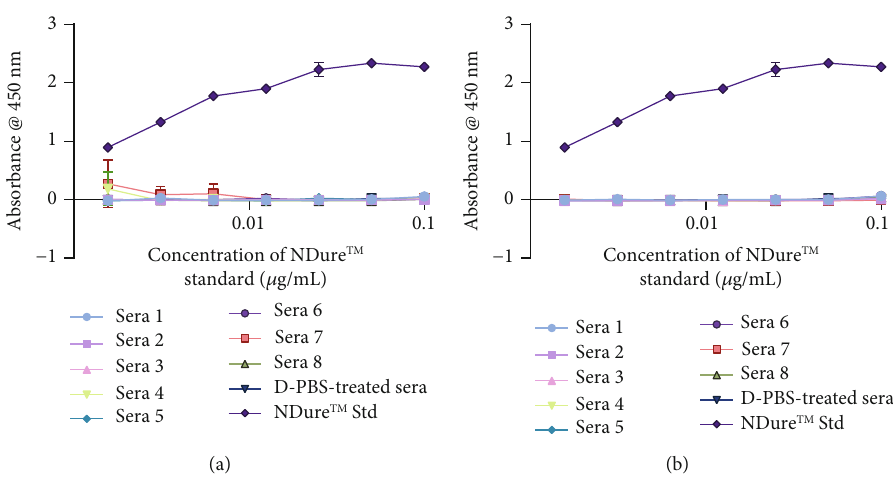
Figure 6: Detection of nonspeci fi c background signals in drug- and D-PBS-treated serum samples . (a – b) Detection of a nonspeci fi c binding response from 1 mg/kg Quad-X ™ - and Humira®-treated mouse serum samples, respectively. In a direct-binding ELISA, 2 μ g/mL human serum albumin (HSA) was used as coating antigen and nonspeci fi c binding was measured using an anti-mouse IgG- (whole molecule) peroxidase antibody. The results shown are the mean ± SD ( n = 2 with three replicates per experiment, except for the pooled NDure ™ Std data which is an n = 4 with two replicates per experiment). p > 0 : 99 for all Quad-X- and Humira-treated serum samples vs. D-PBS-treated serum samples, p < 0 : 0001 for NDure ™ -treated vs. D-PBS-treated serum samples. Results were analysed statistically using a two-way ANOVA with multiple comparison post hoc test ( p > 0 : 05 is considered not signi fi